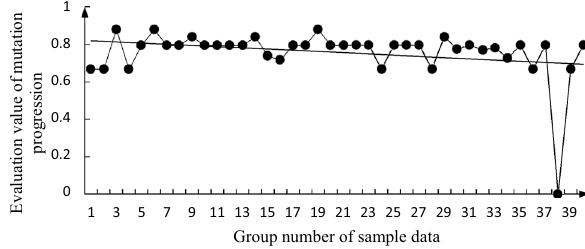
Figure 2. Change trend graph for x F 1 .